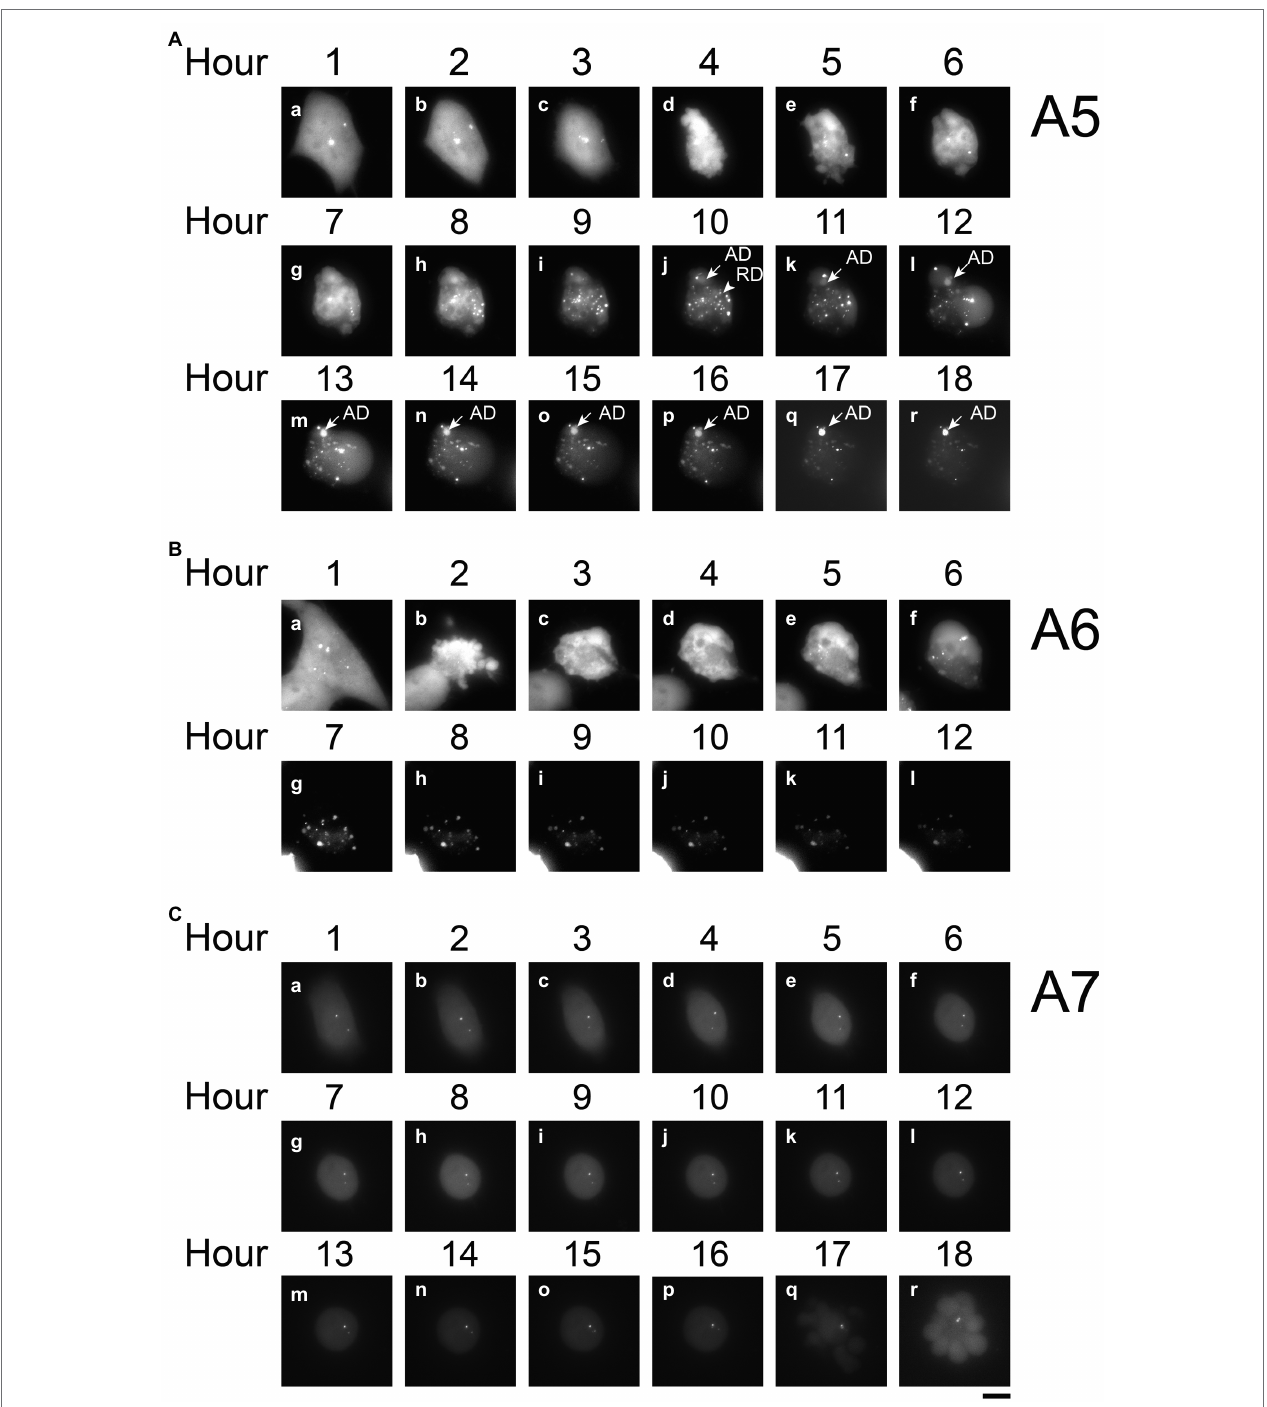
FIGURE 4 | Time-lapse analysis of PB2-vMSL vRNA replication in live cells after IAV infection. A549(MCP-GFPdN) cells were transfected with pHH-PB2- vMSL and infected with two MOI of PR8 IAV at 20 h post-transfection. At 2 h after infection, cells were imaged every hour for 18 h using a Nikon TiE eclipse inverted microscope. RDs (replicated dots) and ADs (apoptosis dots) are indicated by arrows. ADs are primarily static, and are larger in size and have higher signal intensities than RDs. Observations were exemplified by the images captured from representative Cells A5 (A) , A6 (B) , and A7 (C) at the indicated time points, and images are shown as the square of maximum intensity projections across the z-planes in ImageJ. Scale bar: 10 μ